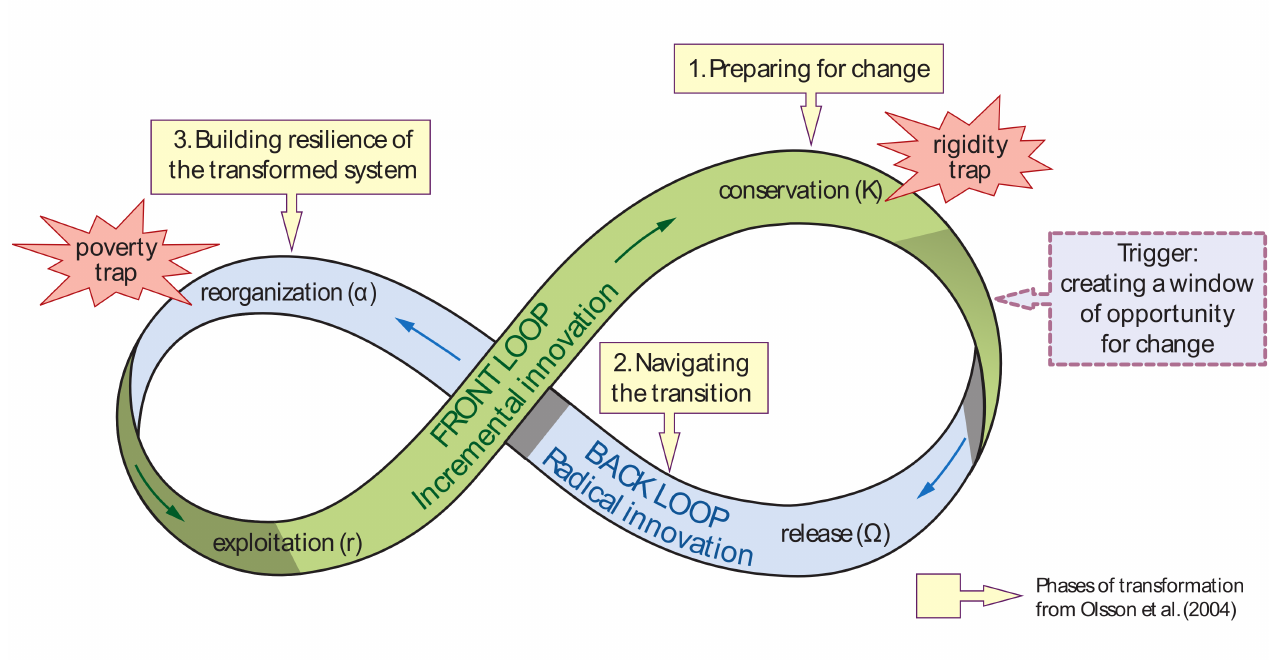
Fig.1. The adaptive cycle (Holling 2001, Gunderson and Holling 2002): a useful metaphor for understanding incremental and radical innovation in complex SES.† Adapted from Panarchy by Lance H. Gunderson and C. S. Holling, editors. Copyright © 2002 Island Press. Reproduced by permission of Island Press, Washington,